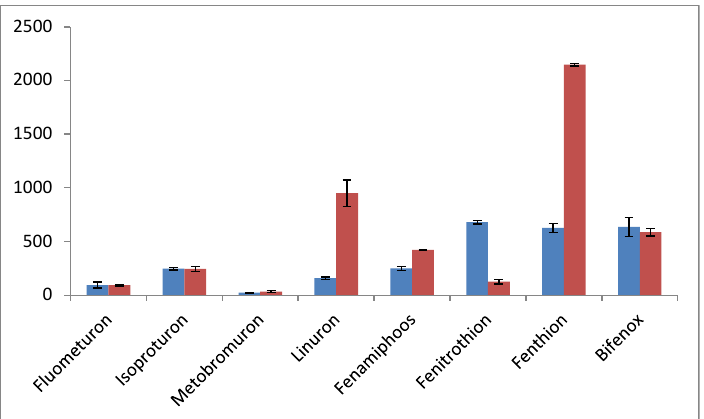
Figure 4. Comparison of the peak areas obtained with the TEOS-MTEOS coated capillaries functionalized with SiO 2 NPs and TiO 2 NPs. Concentrations assayed, 25 ng/mL for linuron and 10 ng/mL for the rest of compounds.